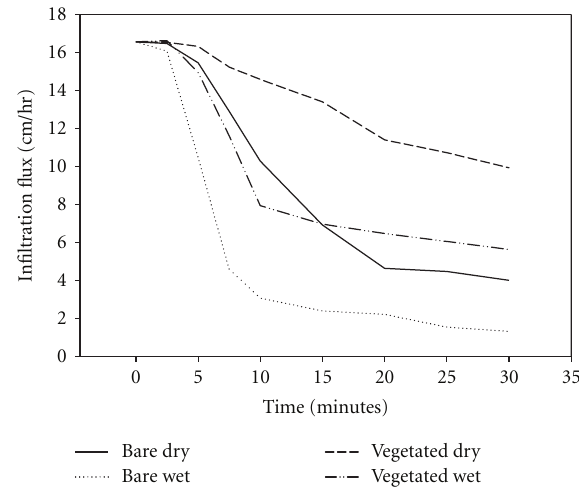
Figure 5: Infiltration flux for Stellar soil with 90Mg biosolidsha − 1 under bare dry, bare wet, vegetated dry, or vegetated wet conditions on the Sierra Blanca